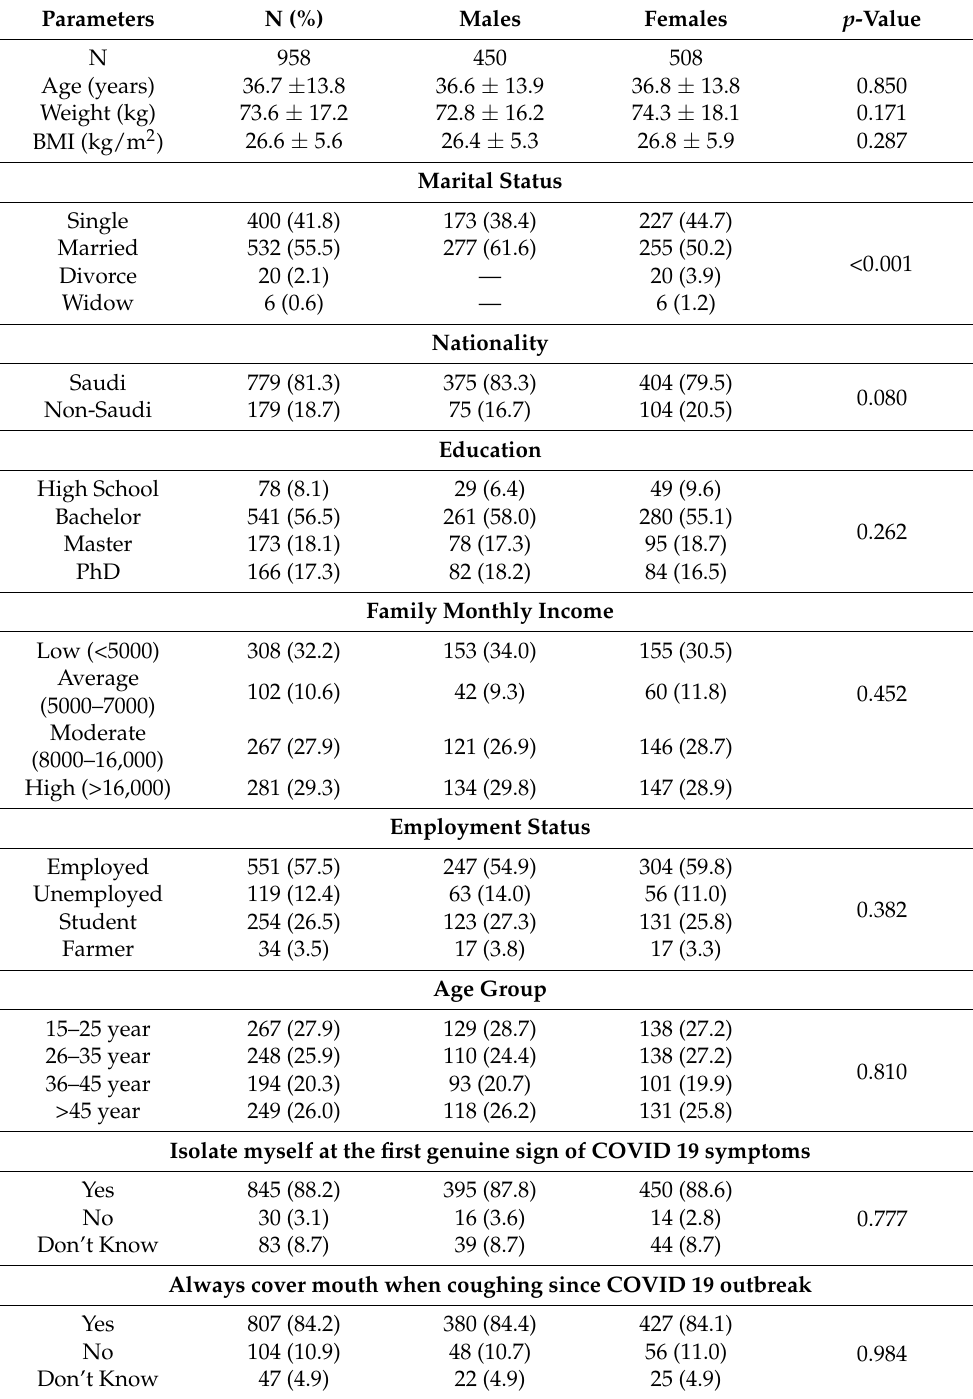
Table 1. General information on the survey